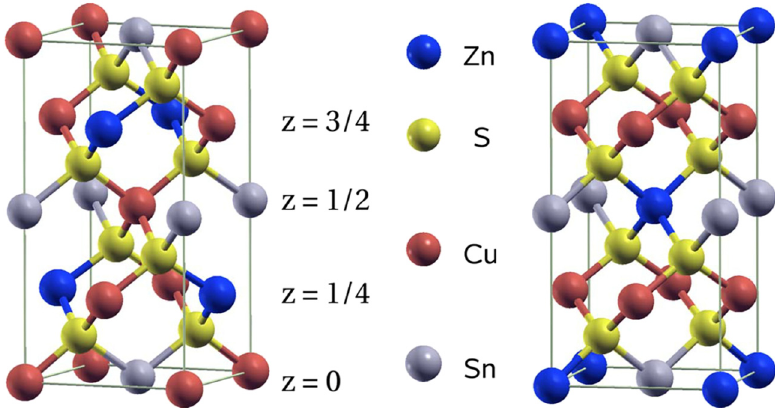
Figure 2: Kesterite ( left ) and stannite ( right ) structures of CZTS material. Reprinted with permission from ref. [ 39 ] . ©2009 American Physical